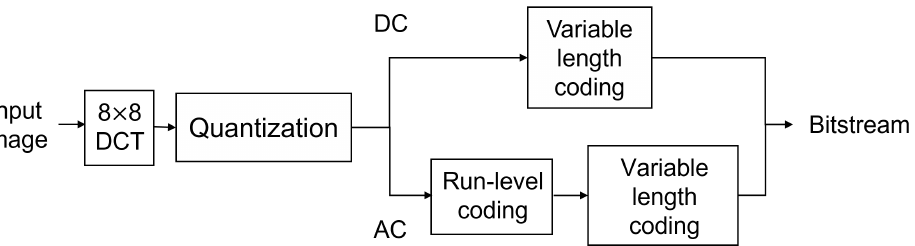
Figure 1. Flow chart for baseline JPEG for an image. An input image will go through multiple operations, including the discrete cosine transform (DCT), quantization, differential coding, and variable-length coding. The output is a bitstream with headers and markers containing side informa- tion for the